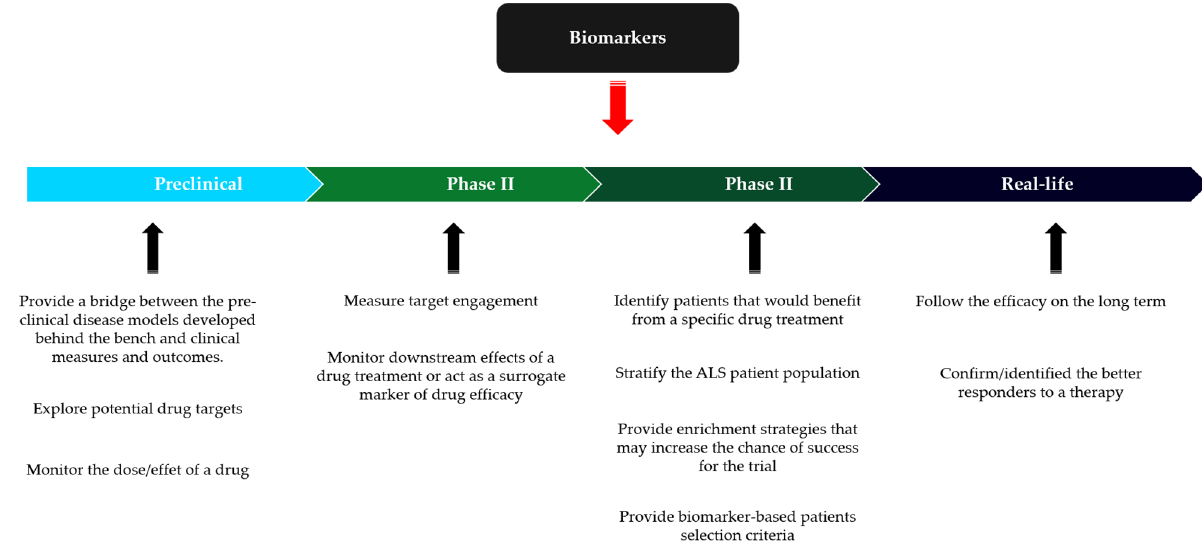
Figure 2. Summaries the utility of biomarkers in drug development in ALS spans from preclinical models, with translational biomarkers, to real-life studies.